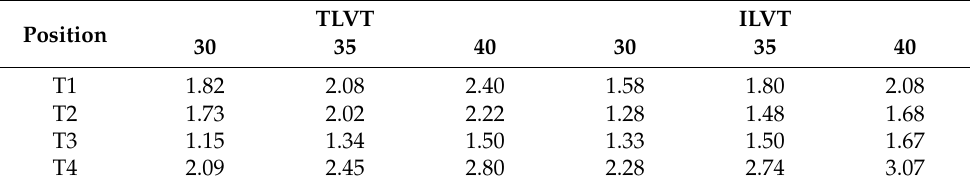
Table 8. Stress value at No. 11 loading point under vertical load (MPa).